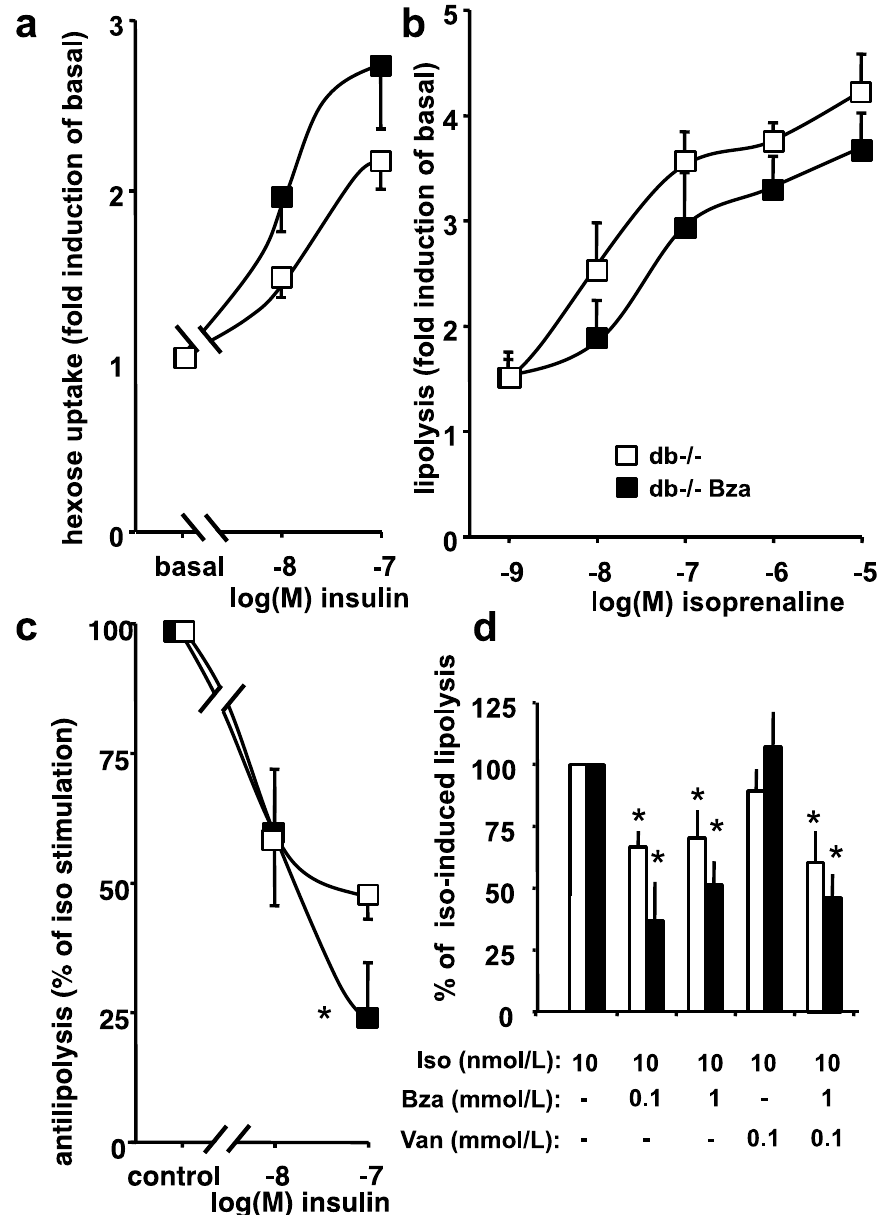
Figure 5. Influence of benzylamine supplementation on glucose transport and lipolytic activities in adipocytes from obese/diabetic mice. ( a ) Hexose uptake in response to insulin, relative to basal [ 3 H]-2-deoxyglucose uptake in control (open squares) and Bza-drinking db-/- mice (closed squares). ( b ) Dose-dependent isoprenaline stimulation of lipolysis expressed as increase over basal glycerol release. ( c ) Inhibition by insulin stimulated lipolysis, expressed as percentage of the stimulation induced by 10 nmol/L of the β -adrenergic agonist isoprenaline. Difference significant at: * p < 0.05 for db-/- vs. Bza-drinking db-/-. ( d ) Inhibition by benzylamine (Bza) alone or in the presence of vanadium (Van) of isoprenaline-stimulated lipolysis (Iso), expressed as percentage of glycerol release. Different from 10 nmol/L isoprenaline alone at: * p < 0.05. Means ± S.E.M. of 4–6 adipocyte prepara- tions/group.